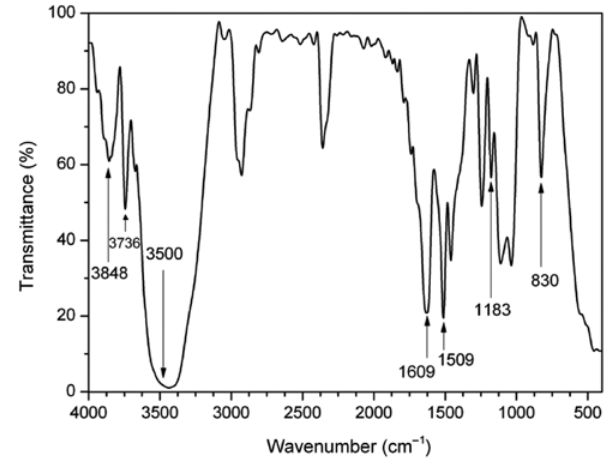
Figure 3: Elemental analysis of neat epoxy in 25% hardener to epoxy ratio.